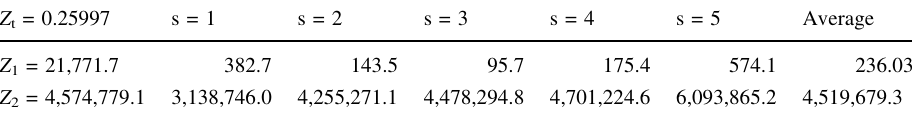
Table 6 The objective function values ( St s ; Swt s )